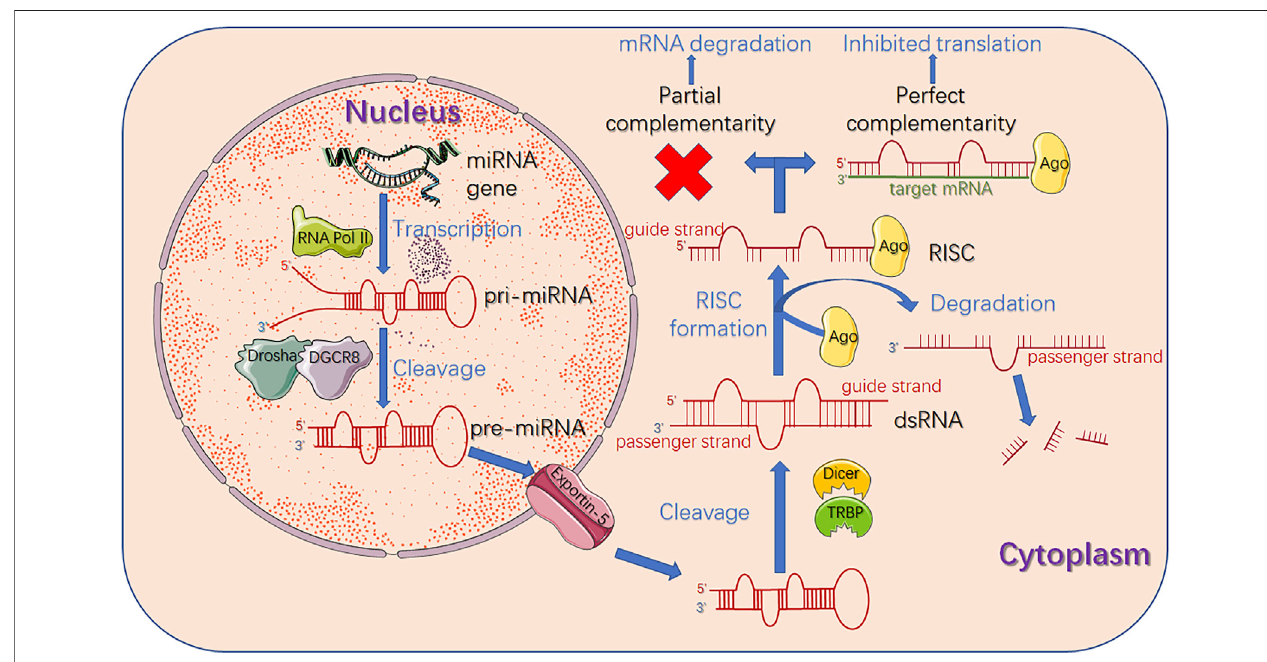
FIGURE 3 | Biogenesis and functions of miRNA. Atthebeginning,miRNAgeneistranscribedtopri-miRNAbyRNApolymeraseII.ThenRNAseIIIDroshaanditscofactor protein DGCR8 bind to pri-miRNA to generate pre-miRNA through enzymatic cleavage. Subsequently, pre-miRNA is exported to cytoplasm via Exportin fi ve and fi nally cleaved into dsRNAbyDicer/TRBPcomplex,whichcanbeseparatedintoguidestrandandpassengerstrand.Afterthecleavageofpassengerstrand,theremanentguidestrandbindstoAgoto form RISC, which mediatestherecognition oftargetmRNA. Judgingby thedegreeofcomplementaritybetween the sequences ofmiRNAand thetargetmRNA,thisleadsto either inhibited translation or mRNA degradation. miRNA: microRNA; RNA Pol II: RNA polymerase II; pri-miRNA: primary miRNA; pre-miRNA: precursor miRNA; dsRNA: double- stranded RNA; Ago: argonaute protein; RISC: RNA-induced silencing complex.